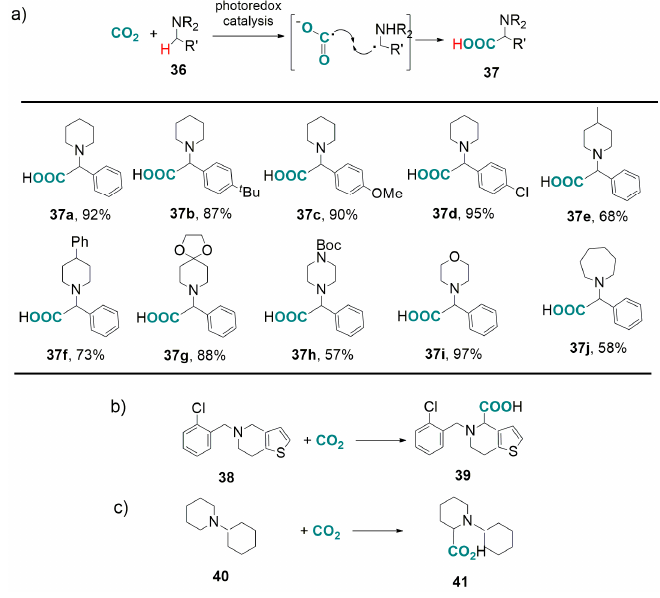
amines α‐ amino acids; Photocatalyzed carboxylation of ticlopidine ( b ) and N ‐ cyclohexylpiperidine ( c